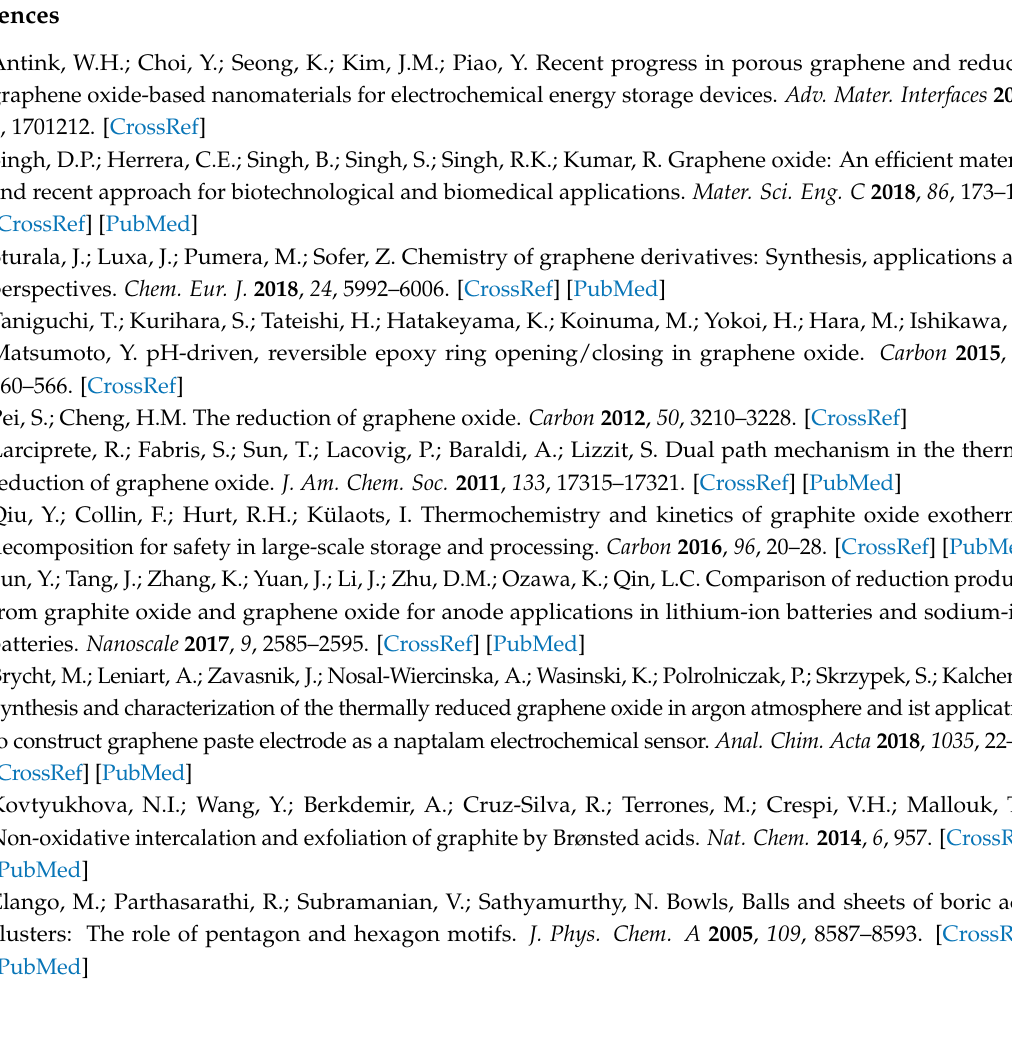
precursor mixture of GOBA/G; (b) BA/C and precursor mixture of GOBA/AA; (c) trGO-GOBA/T; GOBA/AA/T and GOBA/G/T, Figure S3: Raman spectra of obtained samples. Raman spectra of pristine GO and GO/T (a). Raman spectra of mrGO samples (b). Raman spectra of trGO samples (c). Excitation wavelength is 632.8 nm (0.1 mW), Figure S4: SEM images of mrGO and trGO samples: GOBA (a); GOBA/AA (b); GOBA/G (c); GOBA/T (d); GOBA/AA/T (e); GOBA/G/T (f), Figure S5: XRD patterns of precursors and rGO powder (a), mrGO samples (b), trGO samples (c), Figure S6: CVs of the samples on PGE: GOBA (a); GOBA/T (b); GOBA/G (c); GOBA/G/T (d); GOBA/AA (e); and GOBA/AA/T (f). Concentrations are indicated on each graph. Electrolyte was 0.1 M K 2 SO 4 , potential scan rate 100 mV s –1